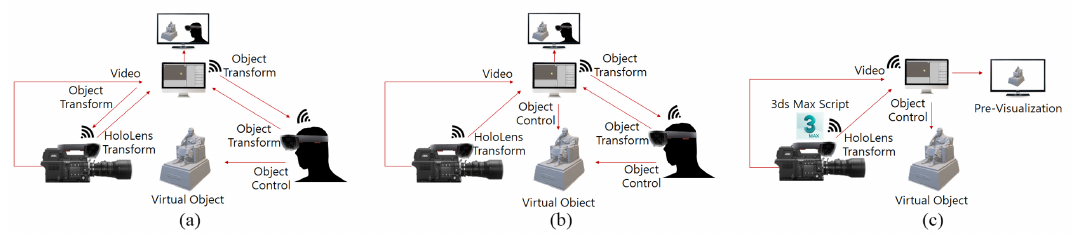
Figure 6. Comparison of HoloLens stream systems: ( a ) Spectator View [21]; ( b ) Holo-Studio [22]; ( c ) proposed